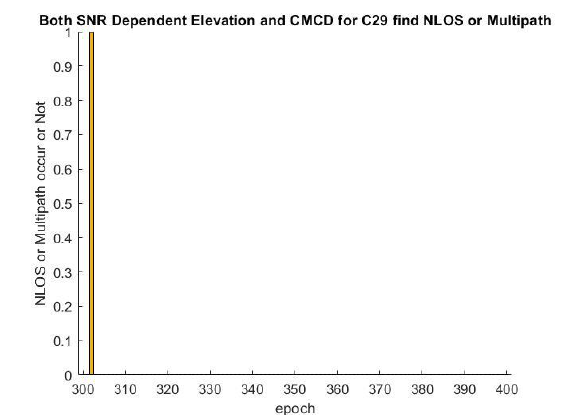
Figure 17. CMCD find NLOS or Multipath for C29 ( In this figure, if multipath or NLOS detected bar shows 1, and if not shows 0. Also in this figure colors do not have special Figure 20. Both SNR Dependent Elevation and CMCD find meaning. ) NLOS or Multipath for E26 ( In this figure, if both criteria detect multipath or NLOS bar shows 1, and if their performance is not the same shows 0. Also, in this figure, colors do not have a special meaning.)